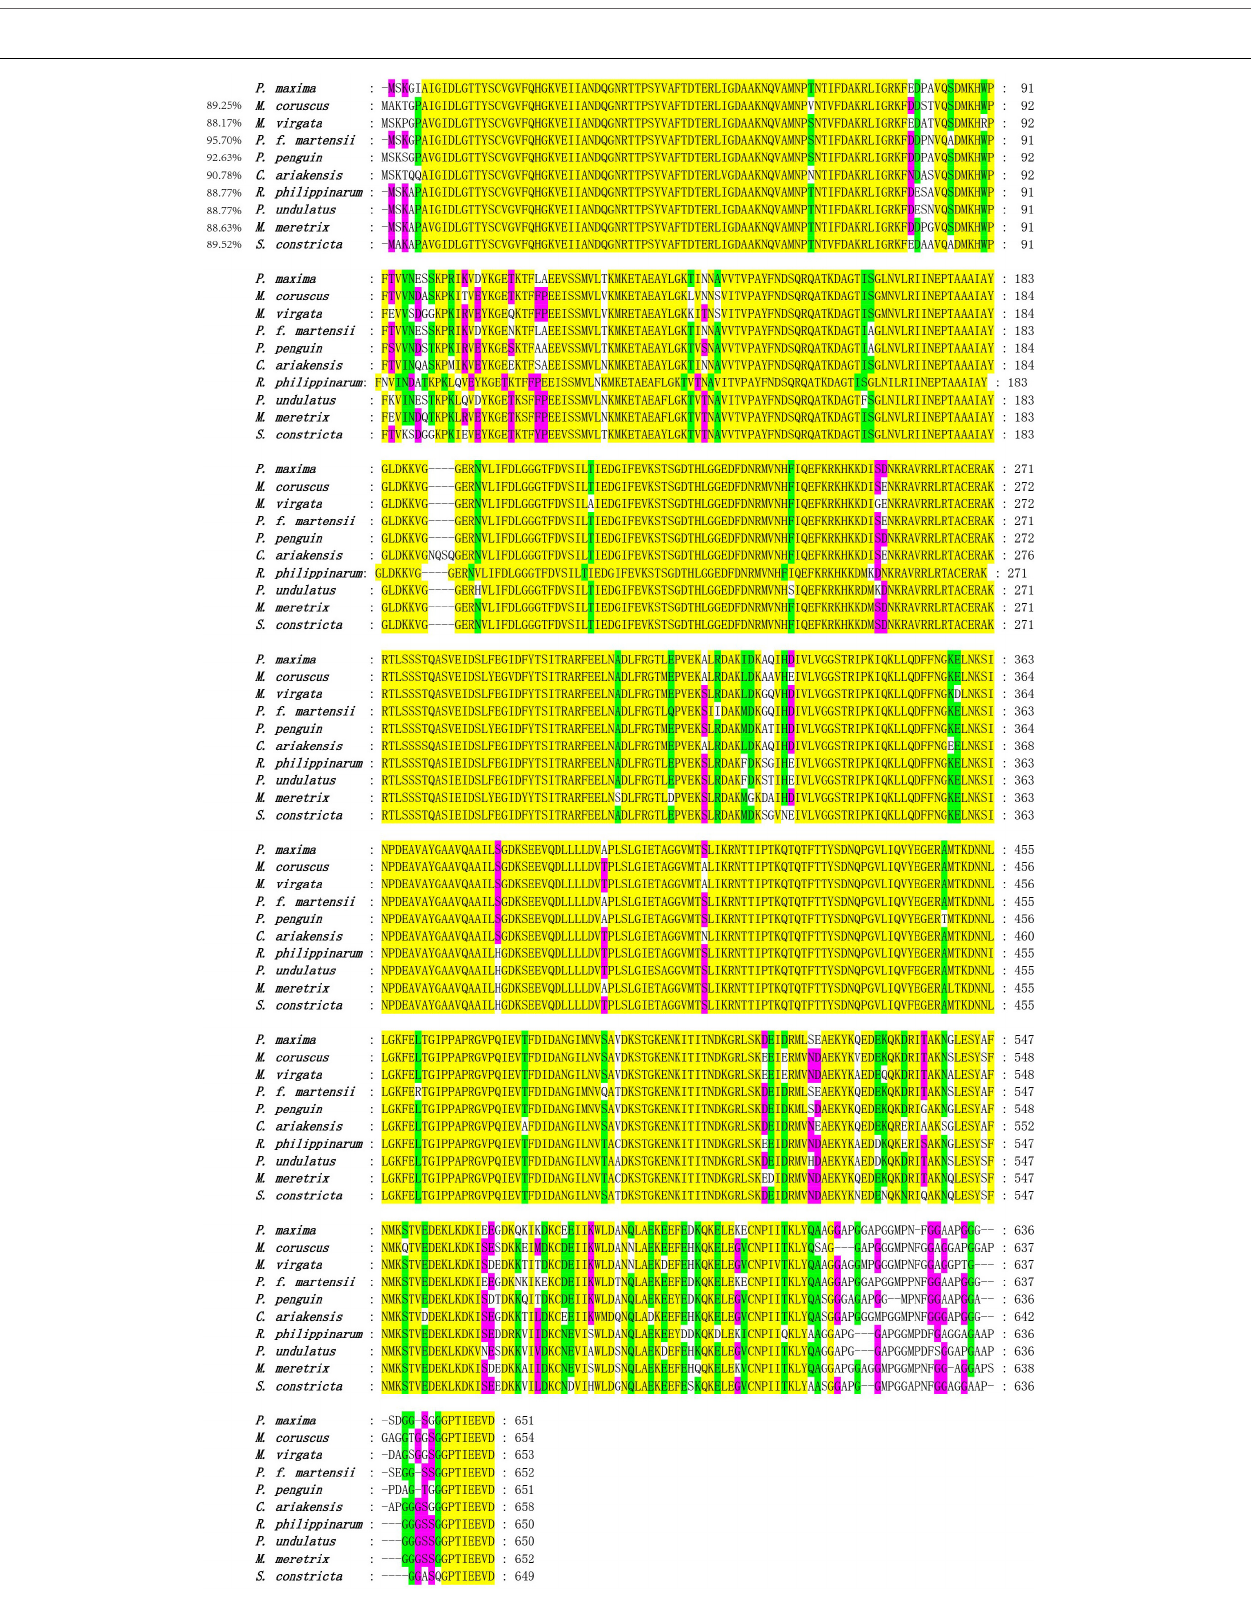
Frontiers in Marine Science |